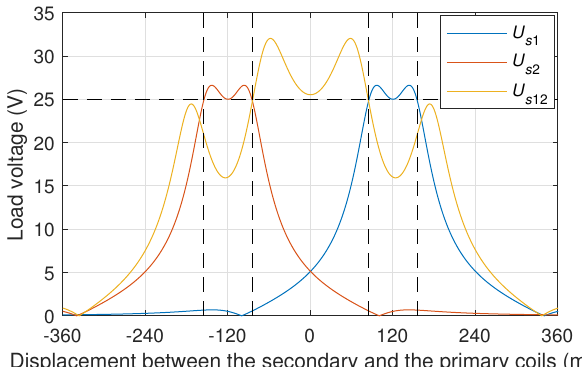
Figure 6. The load voltage simulation diagram of two primary coils working together.